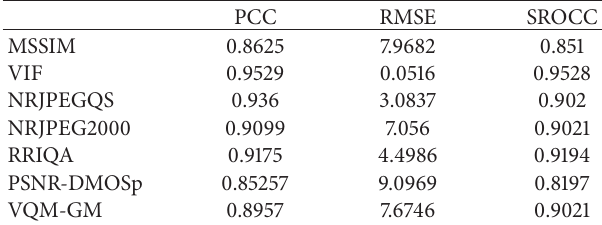
Table 2: Goodness of DMOSp-DMOS